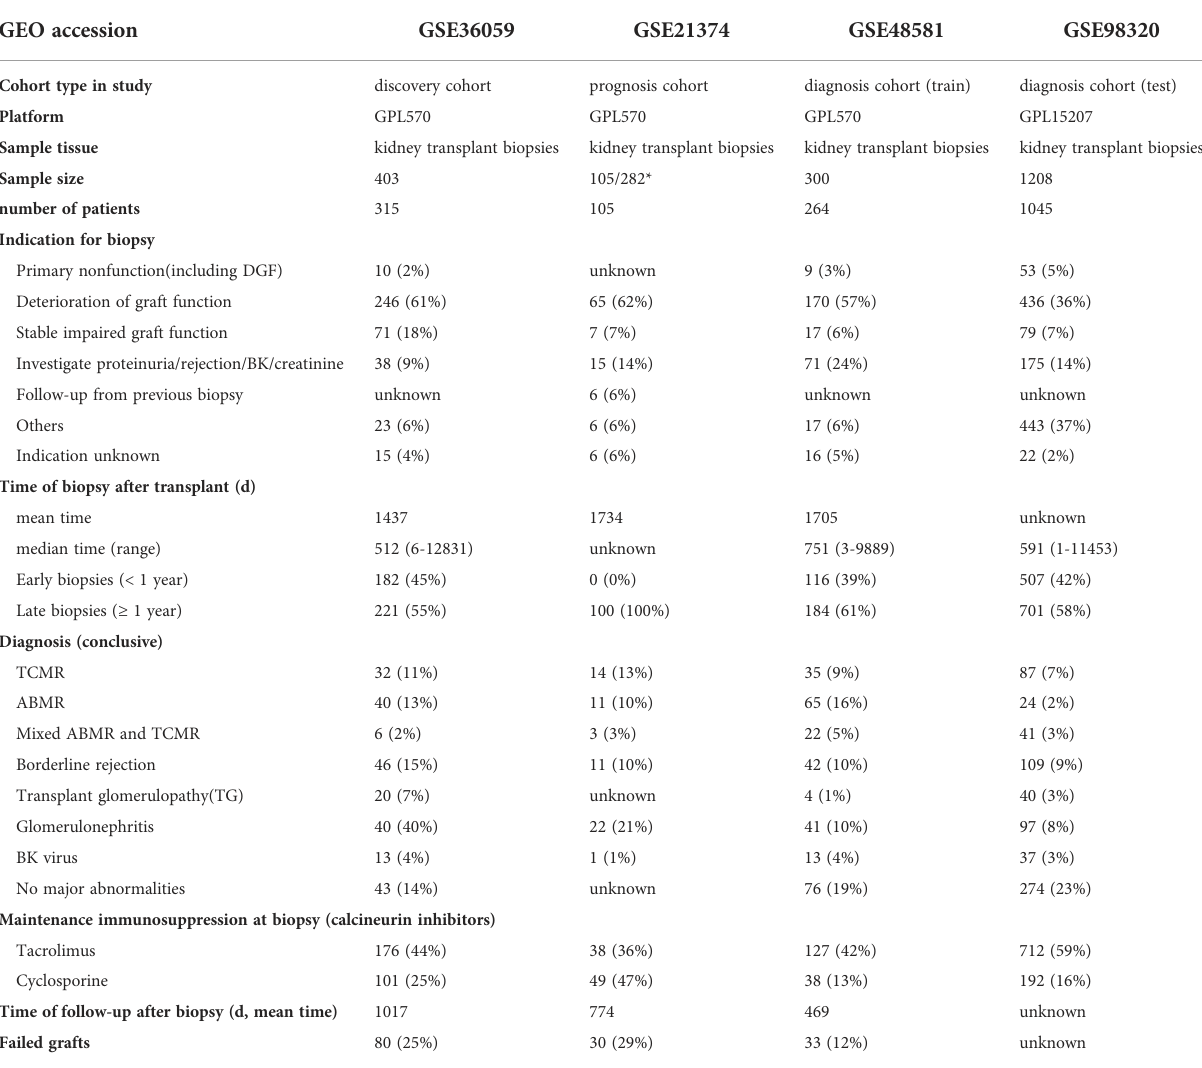
TABLE 1 Characteristic at cohort and